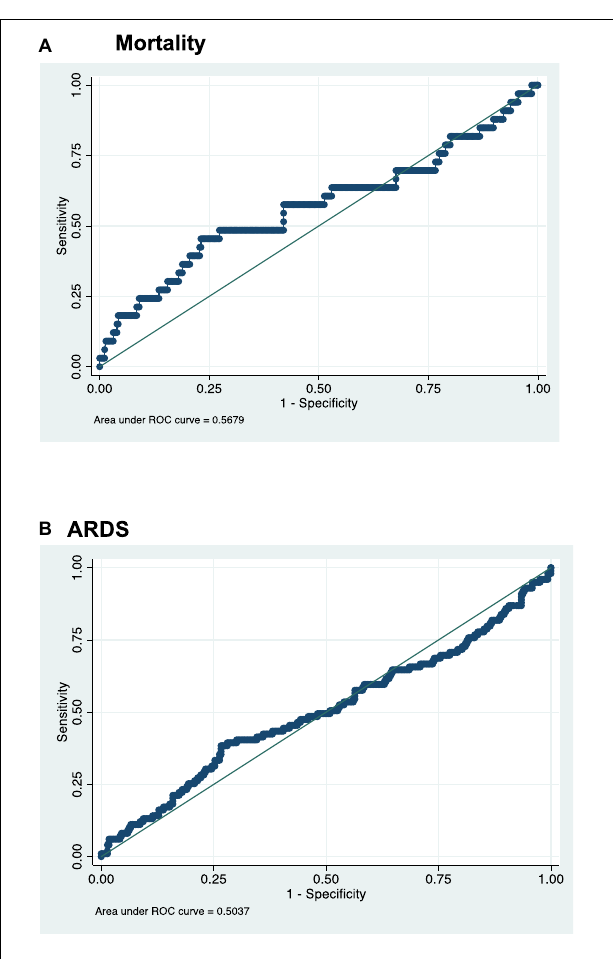
FIGURE 2 | ROC curve for the CD4/CD8 ratio: (A) The best cutoff for mortality discrimination is ≥ 2.027 Sensitivity: 57.58% Specificity: 58.03%; (B) the best cutoff for ARDS discrimination is ≥ 1.945 Sensitivity: 48.48% Specificity: